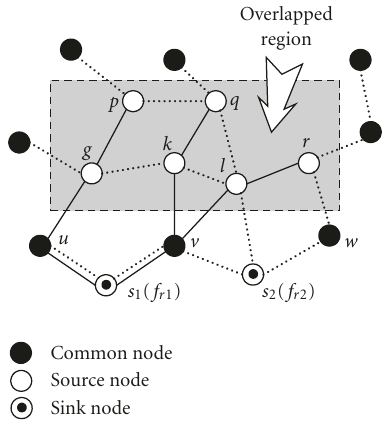
Figure 1: Multirate query example in